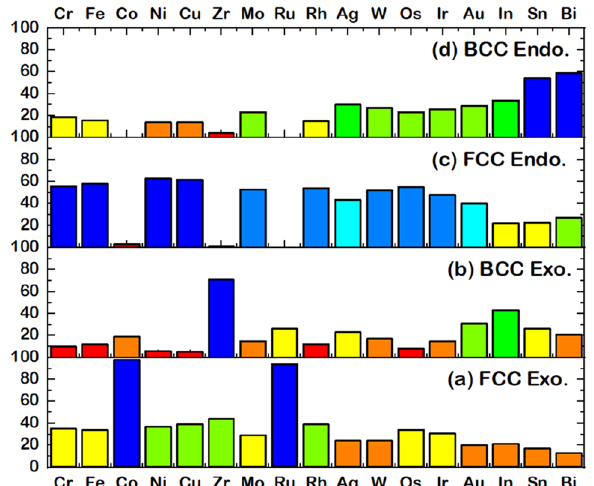
Figure 5. Distribution of elements counted from (cid:31) E f of PtPd XYZ HEAs ( X = Y = Z = Cr, Fe, Co, Ni, Cu, Zr, Mo, Ru, Rh, Ag, W, Os, Ir, Au, In, Sn, Bi) through DFT-calculated results, including ( a ) FCC exothermic cases, ( b ) BCC exothermic cases, ( c ) FCC endothermic cases, and ( d ) BCC endothermic cases. The color classification in each group is based on the frequency of the system found to have either FCC Exo, BCC Exo, FCC Endo, or BCC Endo.